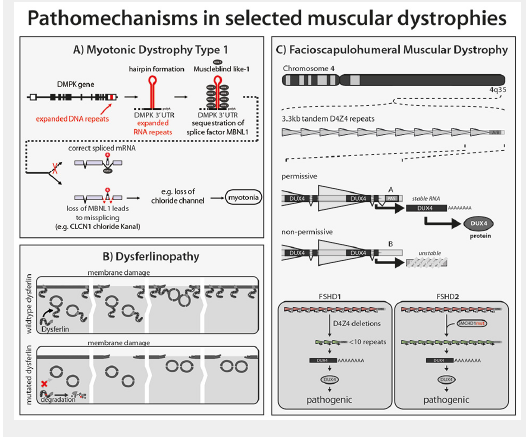
Molecular pathomechanisms in muscular dystrophies. Illustration of the molecular pathomechanisms of myotonic dystrophy type 1 (A), dysferlionpathy (B), and facioscapulohumeral muscular dystrophy (C). (A) Missplicing in myotonic dystrophy type 1 (DM1). The molecular basis of DM1 is an expansion of an unstable repeat sequence in